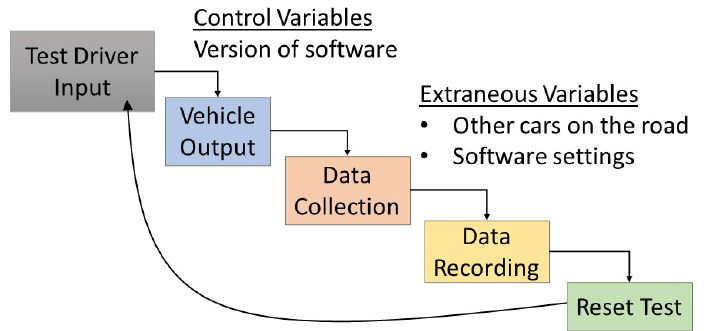
Figure 1. Testing design framework.